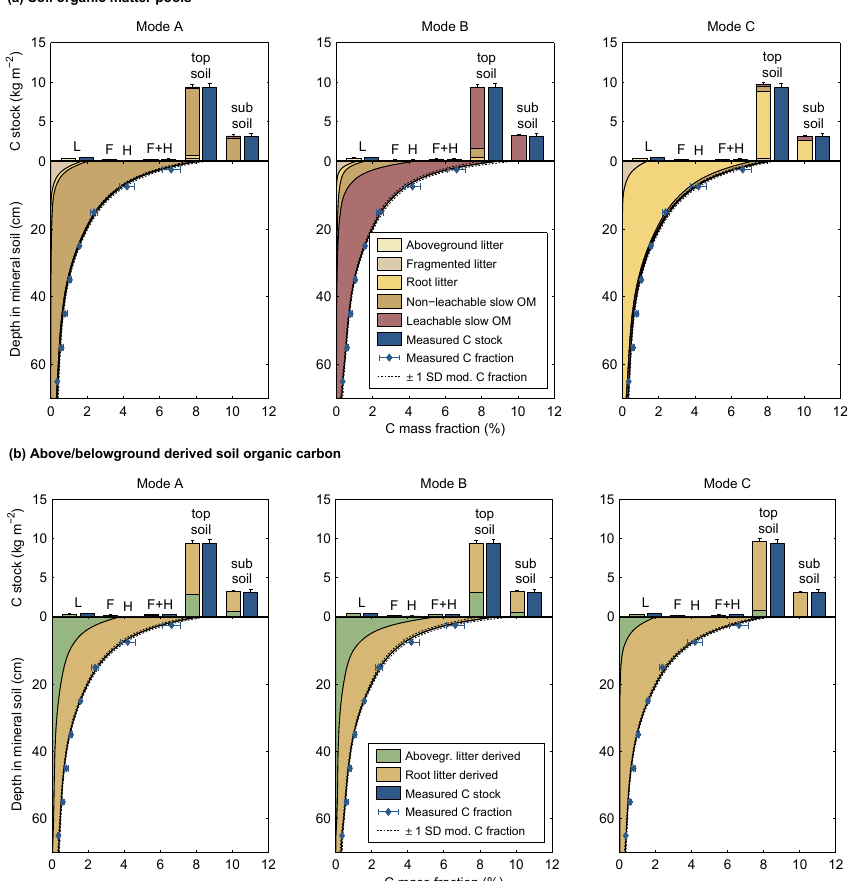
Fig. 8. Organic carbon measurements and corresponding model results of forward Monte Carlo simulations for Hainich, based on the three posterior modes of calibration setup 3. (a) Stocks and fractions of the model pools; (b) above- vs. belowground derived organic matter. L, F, and H refer to the organic horizons (see Sect. 2.1); topsoil: 0–30cm; subsoil: > 30cm; OM: organic matter. All model results are averages over the Monte Carlo ensemble; error bars denote one standard error of the mean for the measurements and one standard deviation (SD) for the model